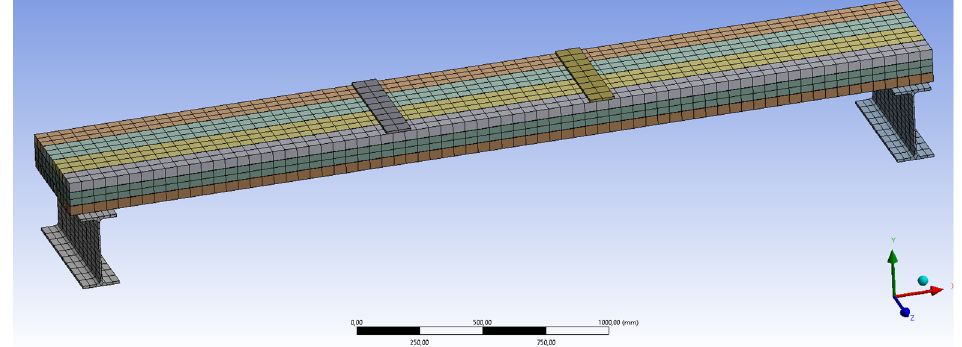
Figure 8. The numerical model in ANSYS Workbench (the finite element mesh).